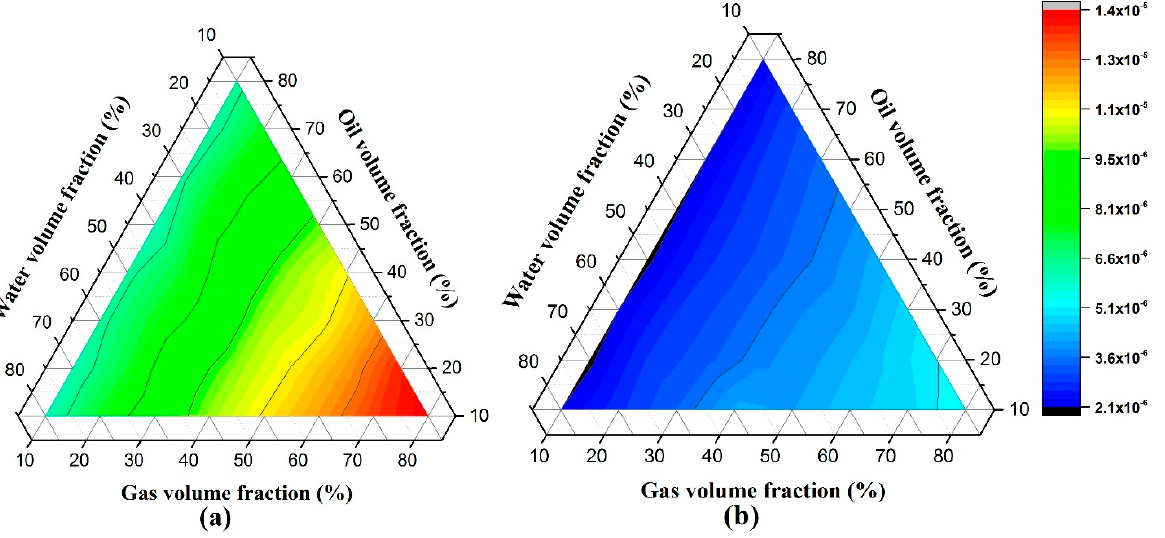
Figure 9. Recorded counts under photo peaks of 241 Am in the second detector versus gas, oil, and water volume fraction: ( a ) scale thickness is 0, ( b ) scale thickness is 3 cm.